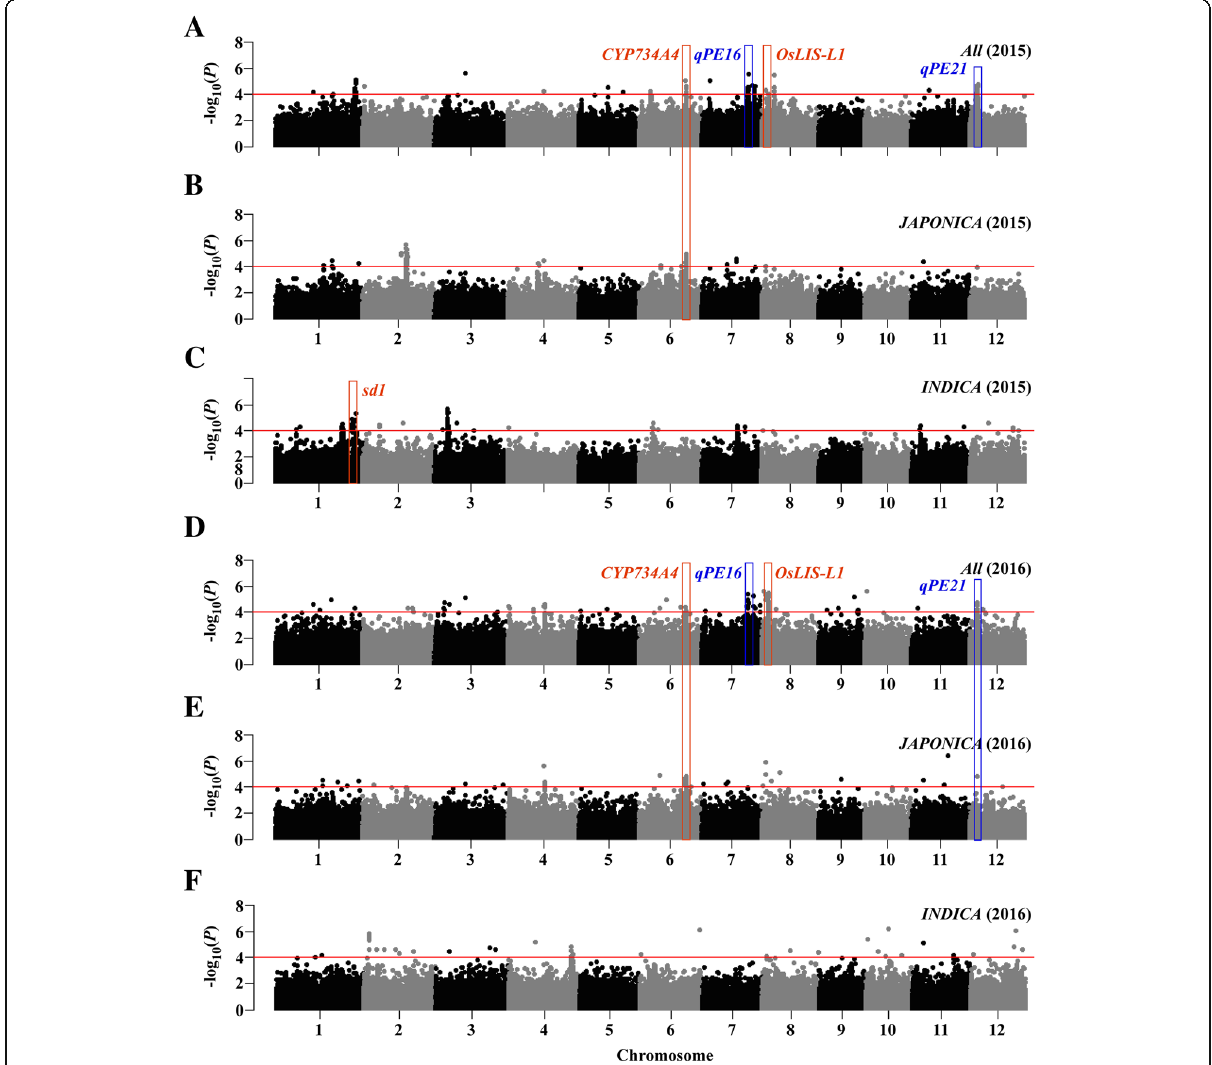
Fig. 2 Genome-wide Manhattan plots of association mapping for PE using the EMMAX model. Associations identified based on All (2015, a ; 2016, d ), JAPONICA (2015, b ; 2016, e ) and INDICA (2015, c ; 2016, f ) groups are depicted in separate panels. The red bar frames indicate the genes reported previously, and the blue bar frames indicate the key novel loci co-located in both 2015 and 2016. The x axis depicts the physical location of SNPs across the 12 chromosomes of rice, and the y axis depicts -log 10 ( P value). Significant SNPs with P ≤ 0.0001 are denoted as red